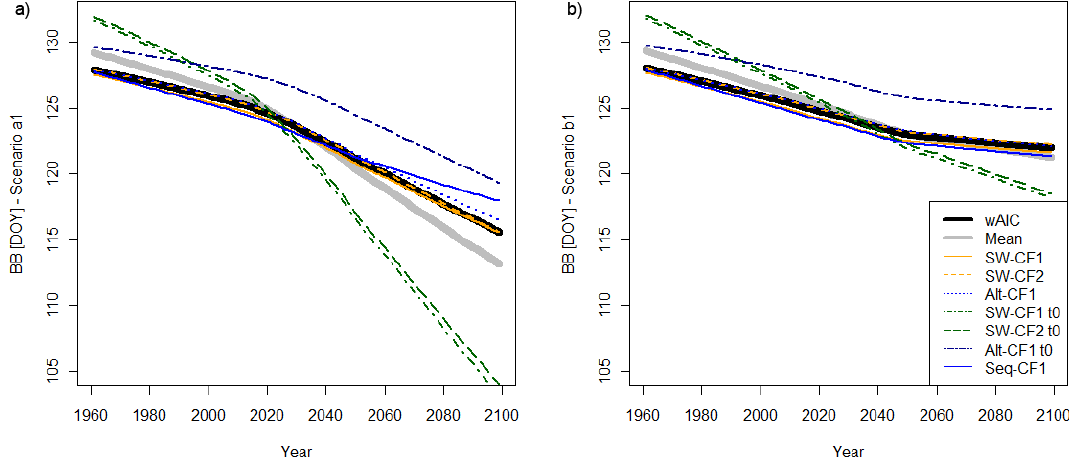
Fig. 6. Smoothed bud-burst (BB) projected time series under the scenario A1fi (a) and the scenario B1 (b) . Different lines represent different models listed in Table 1. Orange lines represent spring warming models with photoperiod limitations; green lines represent spring warming models without photoperiod limitations (starting dates fixed at 1 January); blue lines represent some chilling class models with (alternating, Alt) and without photoperiod limitation (Alt-CF1t0 and sequential, Seq-CF1). The bud-burst projection are smoothed by using a local polynomial regression fitting (Cleveland and Devlin, 1988). Black line represents the Akaike weighted average of model ensembles wile gray line represents the average.